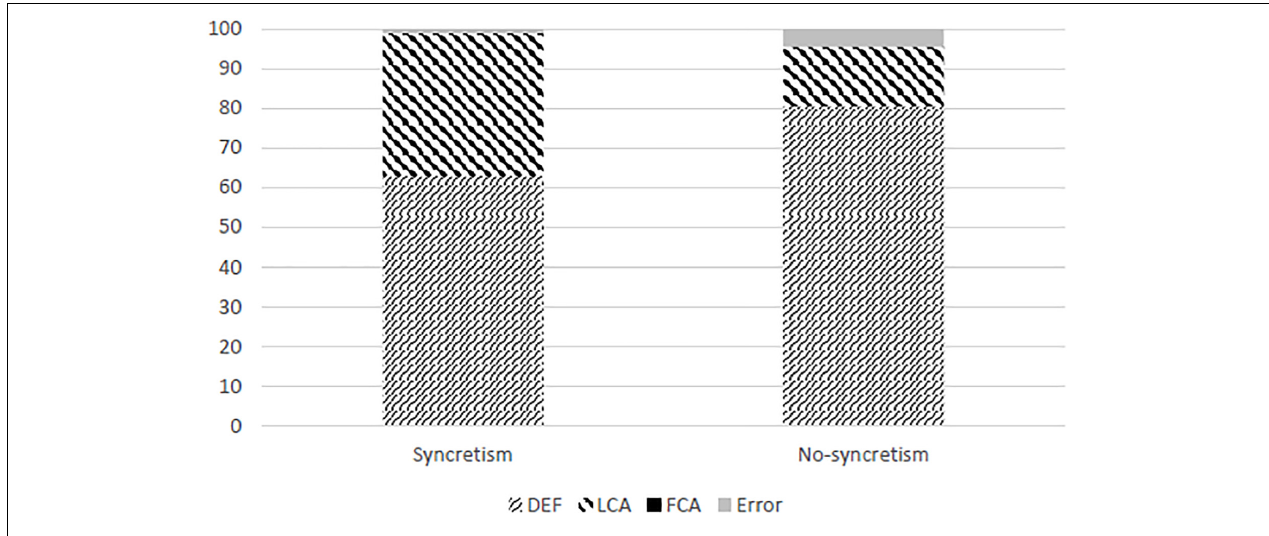
FIGURE 2 | A graphical representation of the produced patterns and